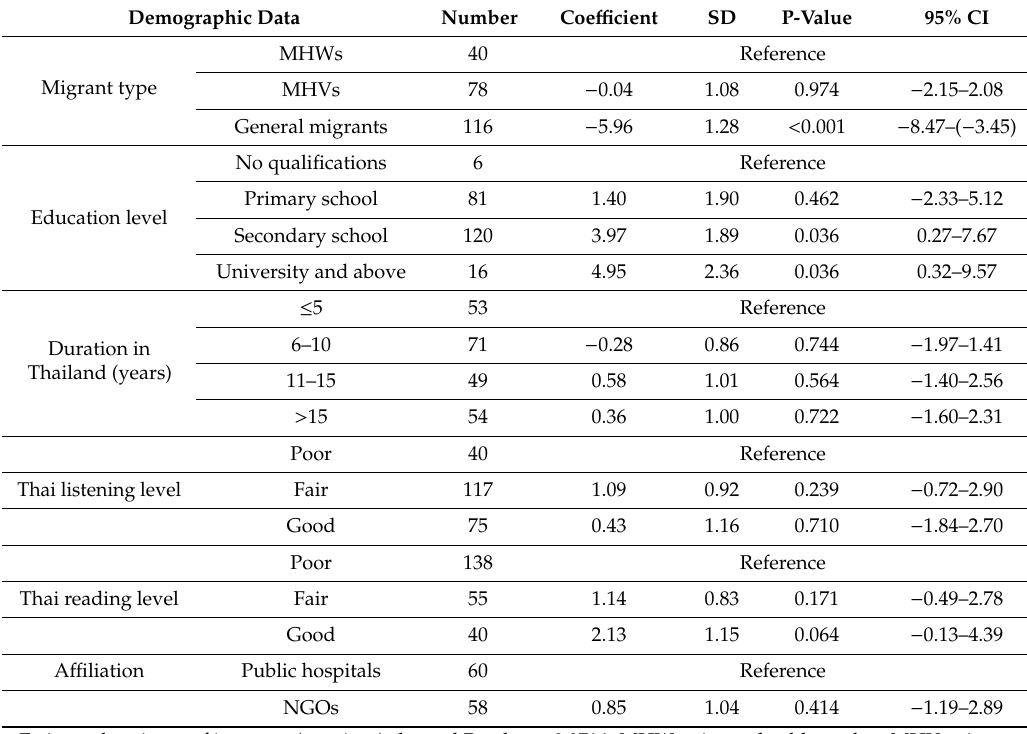
Table 3. Random-intercept model on health literacy